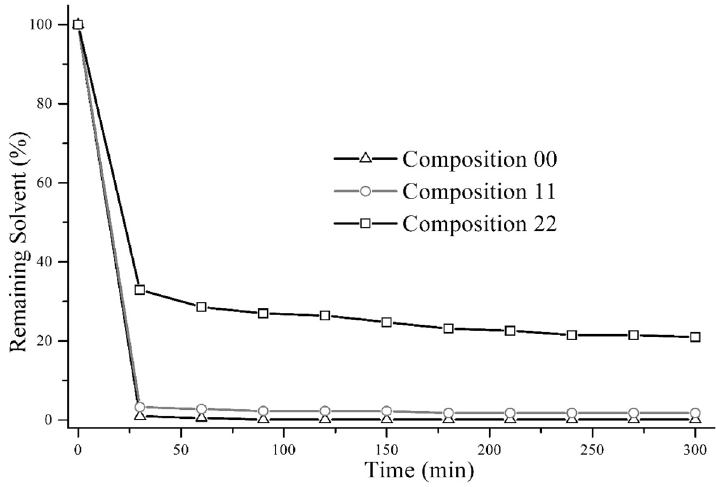
Figure 5. Solvent evaporation from the LCS in terms of remaining solvent amount (%) vs time (min).